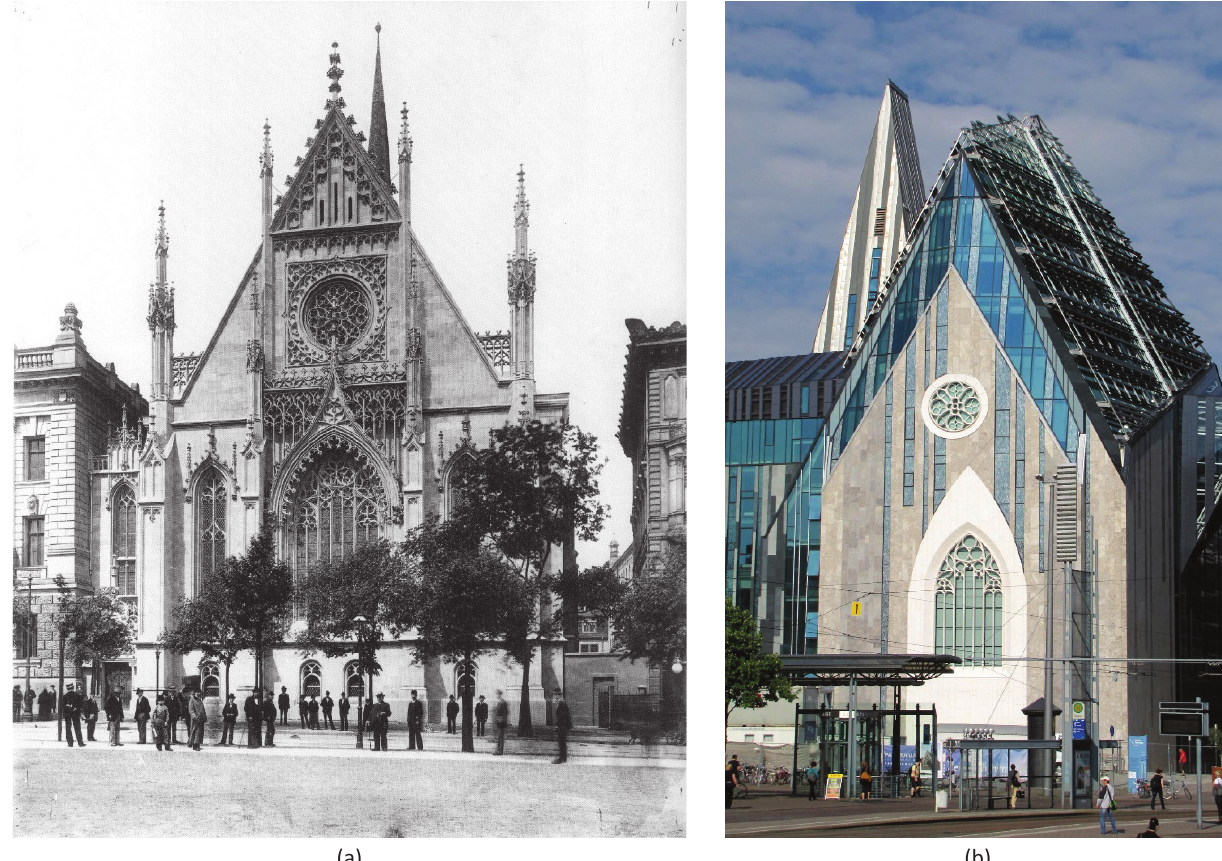
Figure 4. Paulinerkirche (a) and reinterpreted university church (b). Sources: (a) Wikimedia Commons (n.d.) and Wikimedia Commons